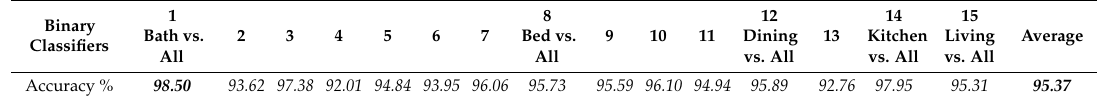
Table 3. 15 binary classifier